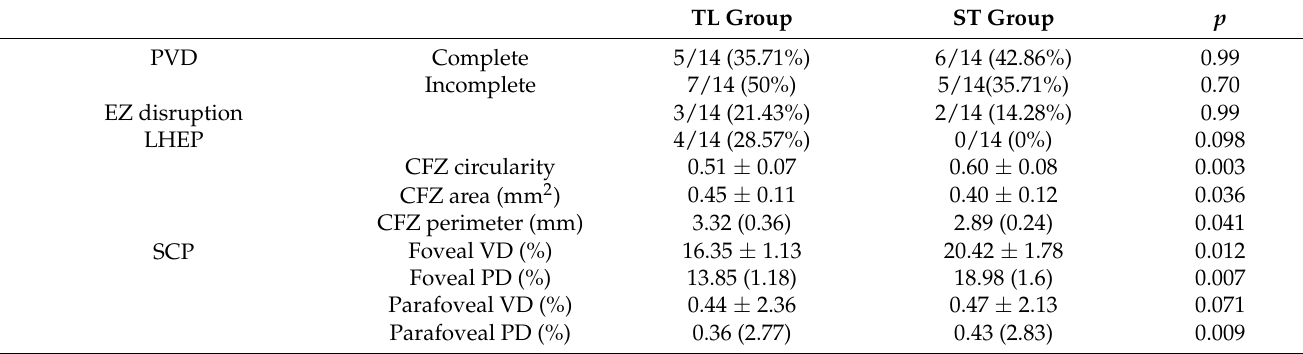
Table 2. Comparison between the two study groups on the basis of OCT-B scan and OCT-A variables of interest. CFZ = capillary free zone; DCP = deep capillary plexus; EZ = ellipsoid zone; LHEP = lamellar hole-associated epireti- nal proliferation; PD = perfusion density; PVD = posterior vitreous detachment; SCP = superficial capillary plexus; ST = stable; TL = tissue loss; VD = vessel